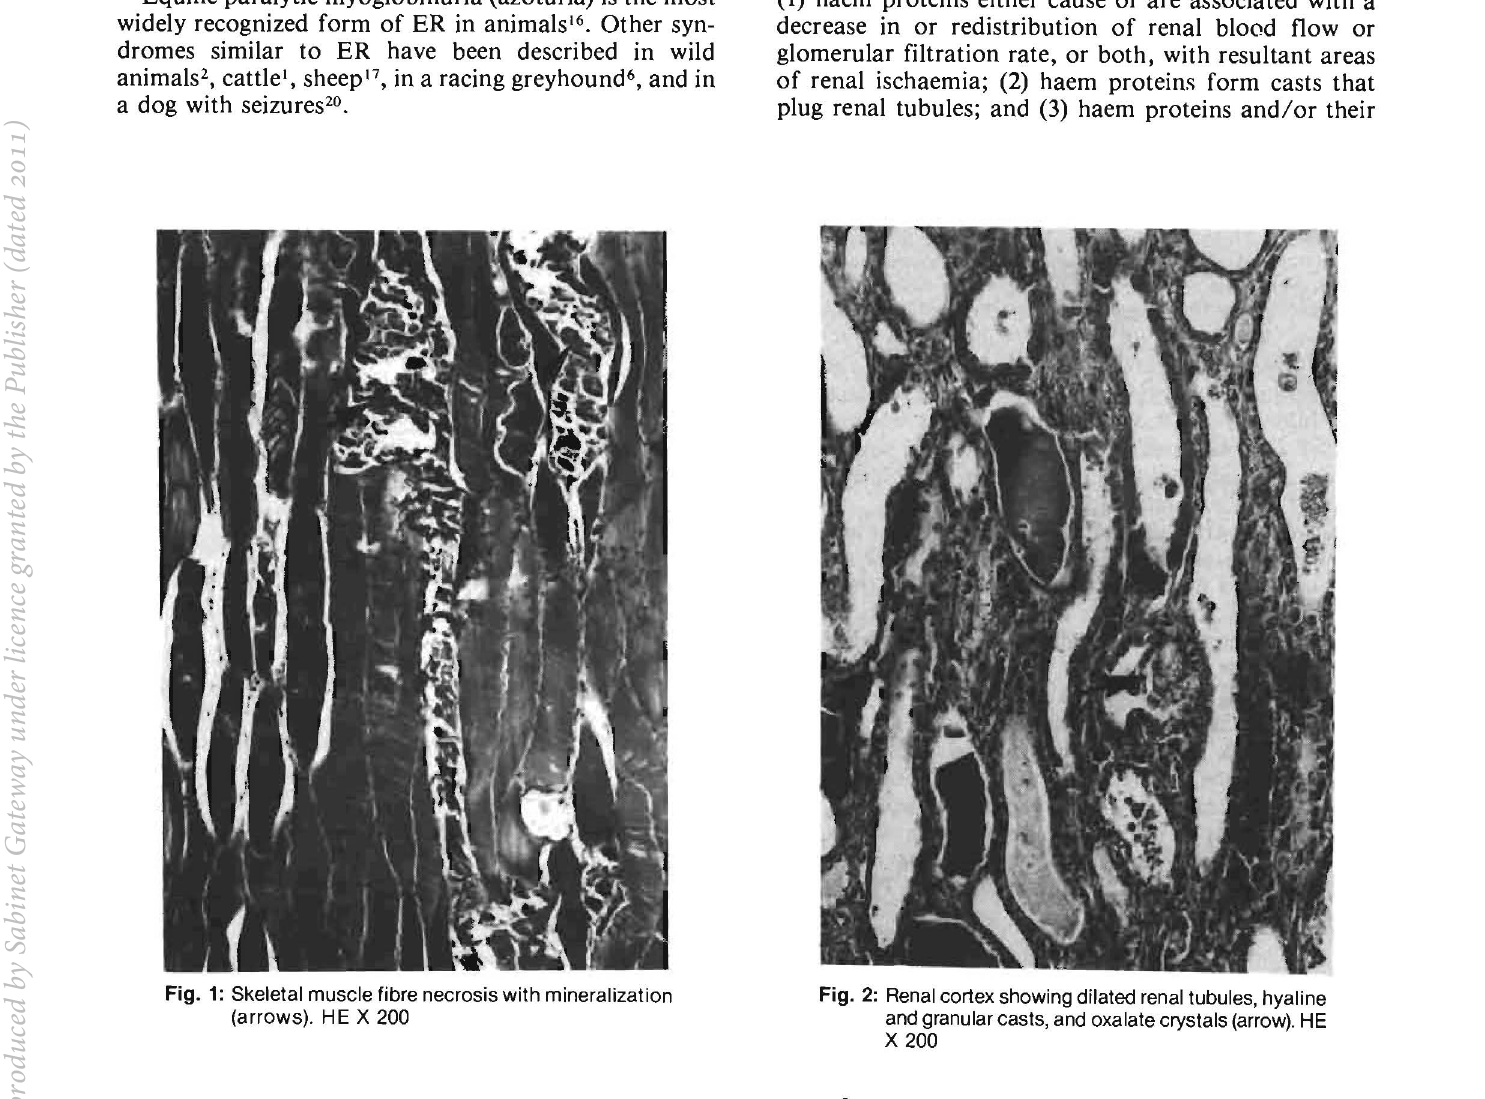
Fig. 2: Renal cortex showing dilated renal tubules, hyaline and granular casts, and oxalate crystals (arrow). HE X 200